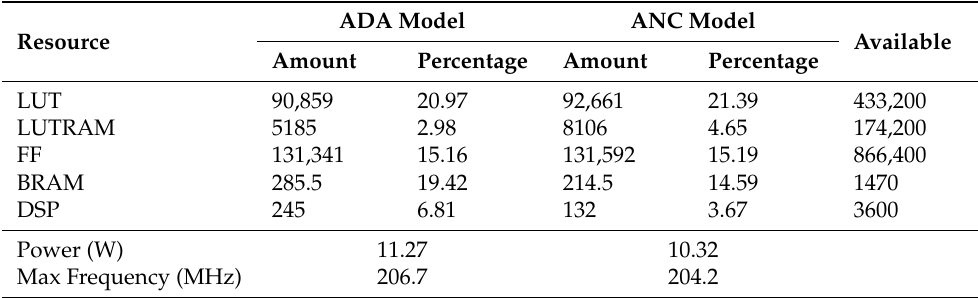
Table 9. Synthesis result of each model design on Virtex 7 XC7V690T